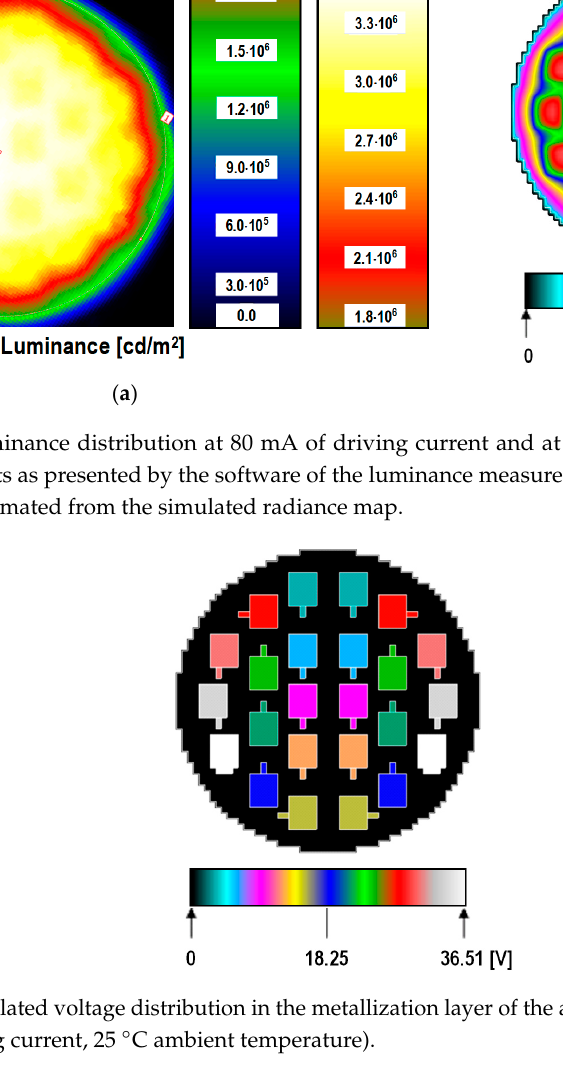
Figure 32. Simulated distributions within the CoB device: ( a ) Junction temperature of the blue LED chips; ( b ) blue radiance at the top of the LED chips; ( c ) vertical distribution of the phosphor temperature, blue radiance and yellow radiance at the location indicated by the green X marker (400 mA driving current, 25 °C ambient temperature).